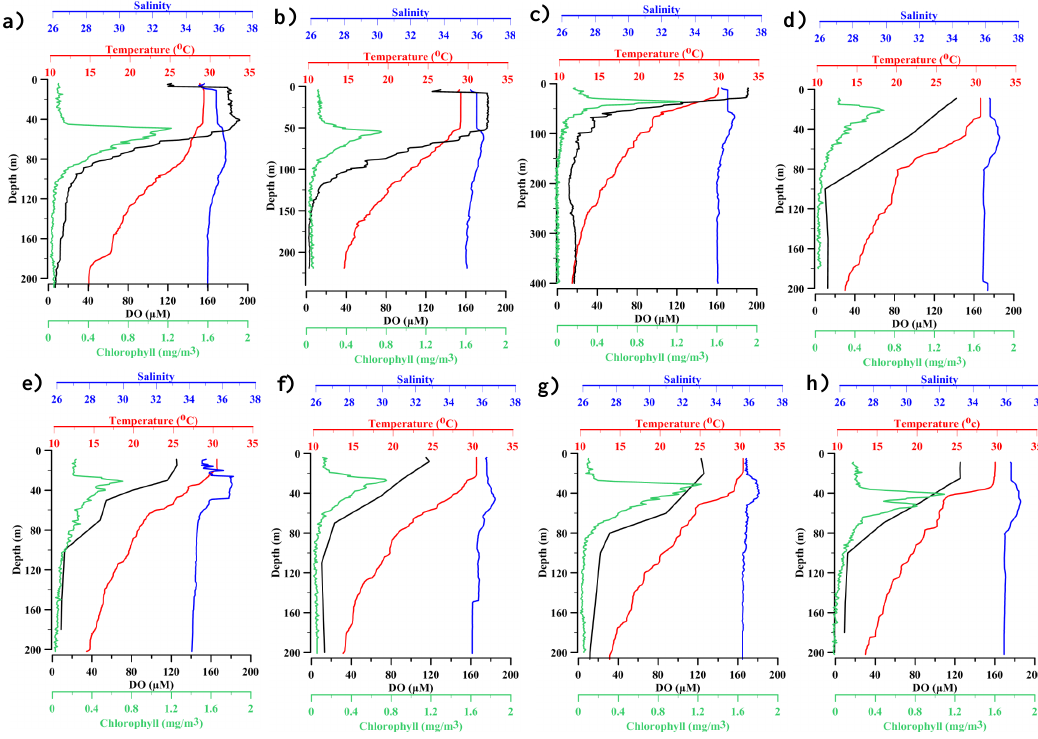
Figure 2. Vertical water column profiles of temperature, salinity, dissolved oxygen and Chlorophyll a concentrations at ( a ) L1 ( b ) L2 ( c ) L4 in 2015 ( d ) L3 ( e ) L4 in 2016 ( f ) L5, ( g ) L6, and ( h )